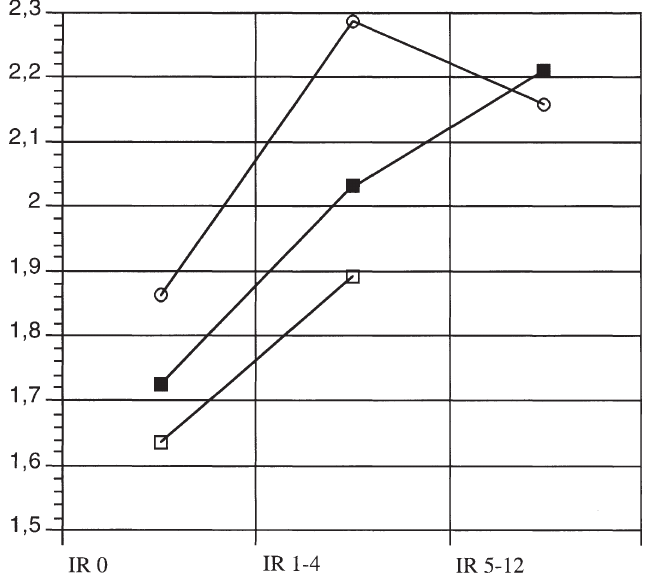
Fig. 2. Standard deviation of the shape factor (S.D. FormFak) in breast cancers with different p53 expression in correlation to the Bloom–Richardson grading. IR 0 . . . p53 negative tumours; IR 1–4 . . . weakly p53 positive tumours; IR 5–12 . . . strongly p53 positive tumours. 1 G1 ∗ ; 2 G2; ! G3. ∗ Excluded from statistical analysis, the number of cases was too small for statistical